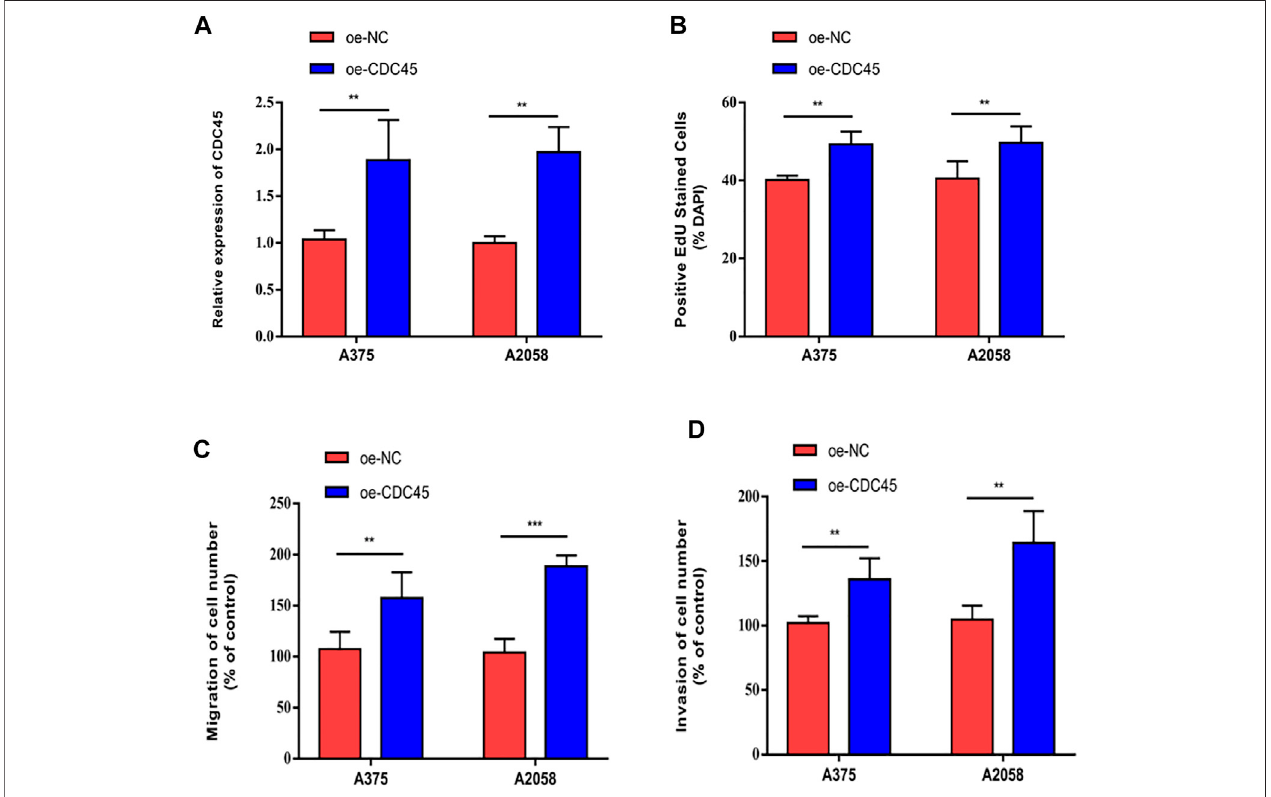
FIGURE4| CDC45promoted melanoma to proliferate, migrate and invade. (A) Transfection ef fi cacy ofoverexpressed plasmidofCDC45; (B) EdU-positive rate in cells overexpressing CDC45; (C) Migration in cells overexpressing CDC45; (D) Invasion in cells overexpressing CDC45. ** p < 0.01; *** p <